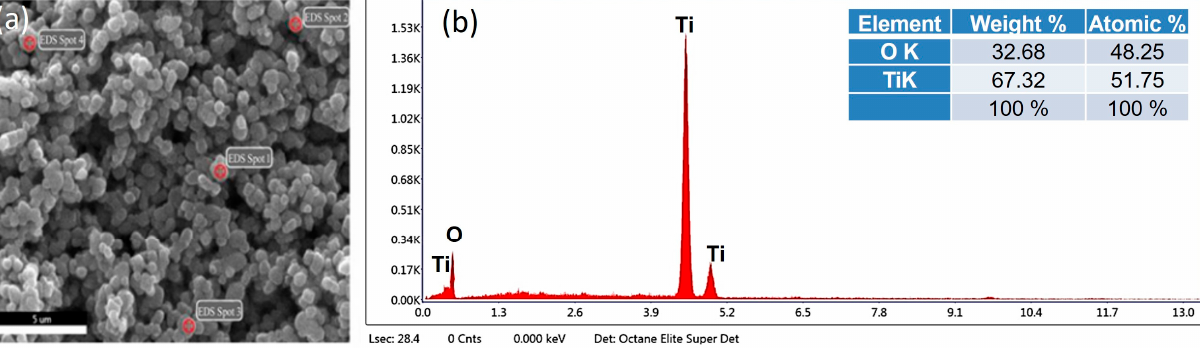
Figure 5. Transmission electron microscopic image of ( a ) TiO 2 nanoparticles synthesized by Bacil- lus subtilis ( b ) Selected area electron diffraction peaks.